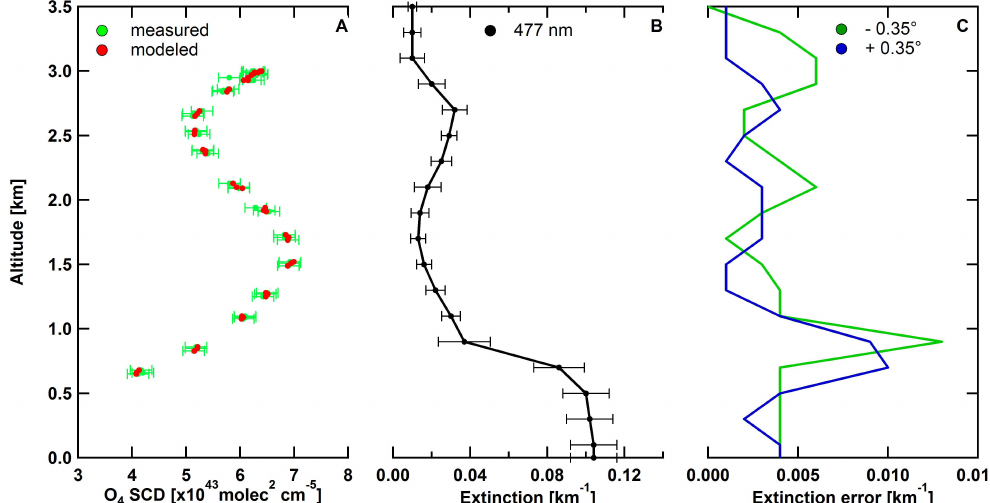
Fig. 10. (A) Measured (green) and simulated (red) vertical profiles of O 4 SCDs for 0 ◦ EA at 477nm from the low approach at Brackett airfield during RF#46 on 16 July 2010 in SCAB. (B) Corresponding aerosol extinction vertical profile retrieved at 477nm. (C) Error contribution in extinction due to angle uncertainty of ± 0.35 ◦ . Note that the aircraft only flew down to ∼ 600ma.g.l. during the low approach, and a set of downward EAs at that altitude was used to probe the lower